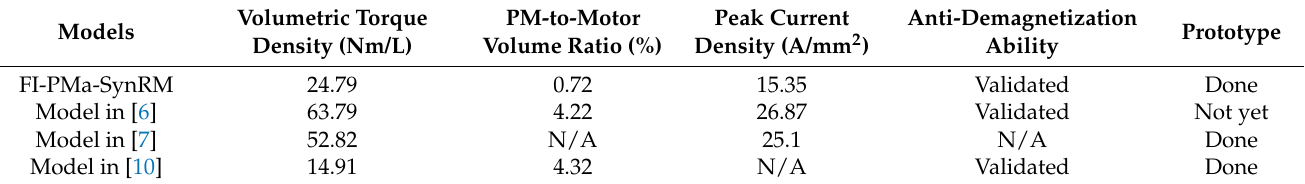
Table A1. Brief information of motor